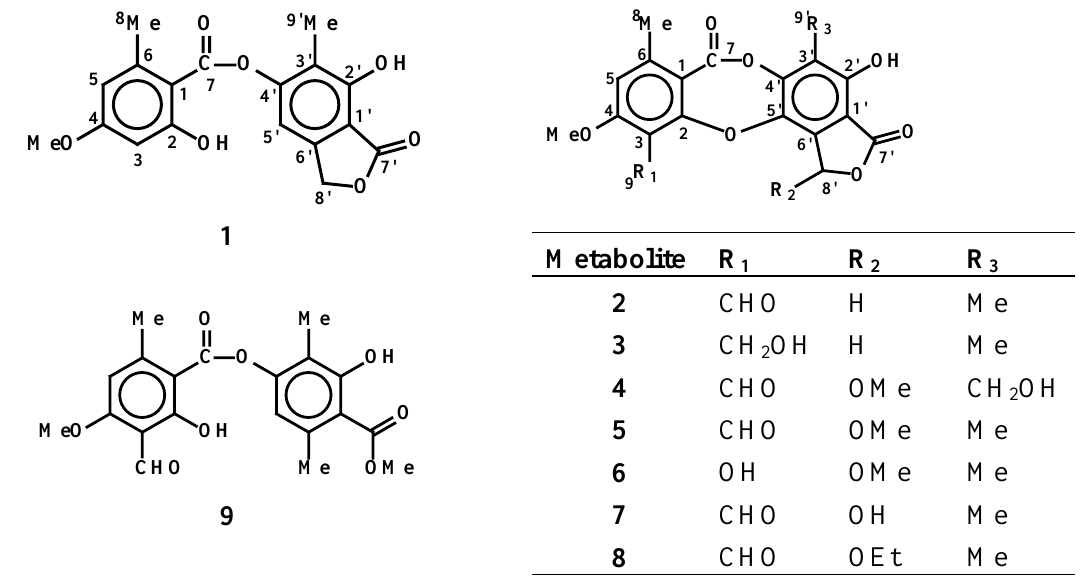
Figure 1. Structures of the compounds isolated from the lichen Hypotrachyna revoluta